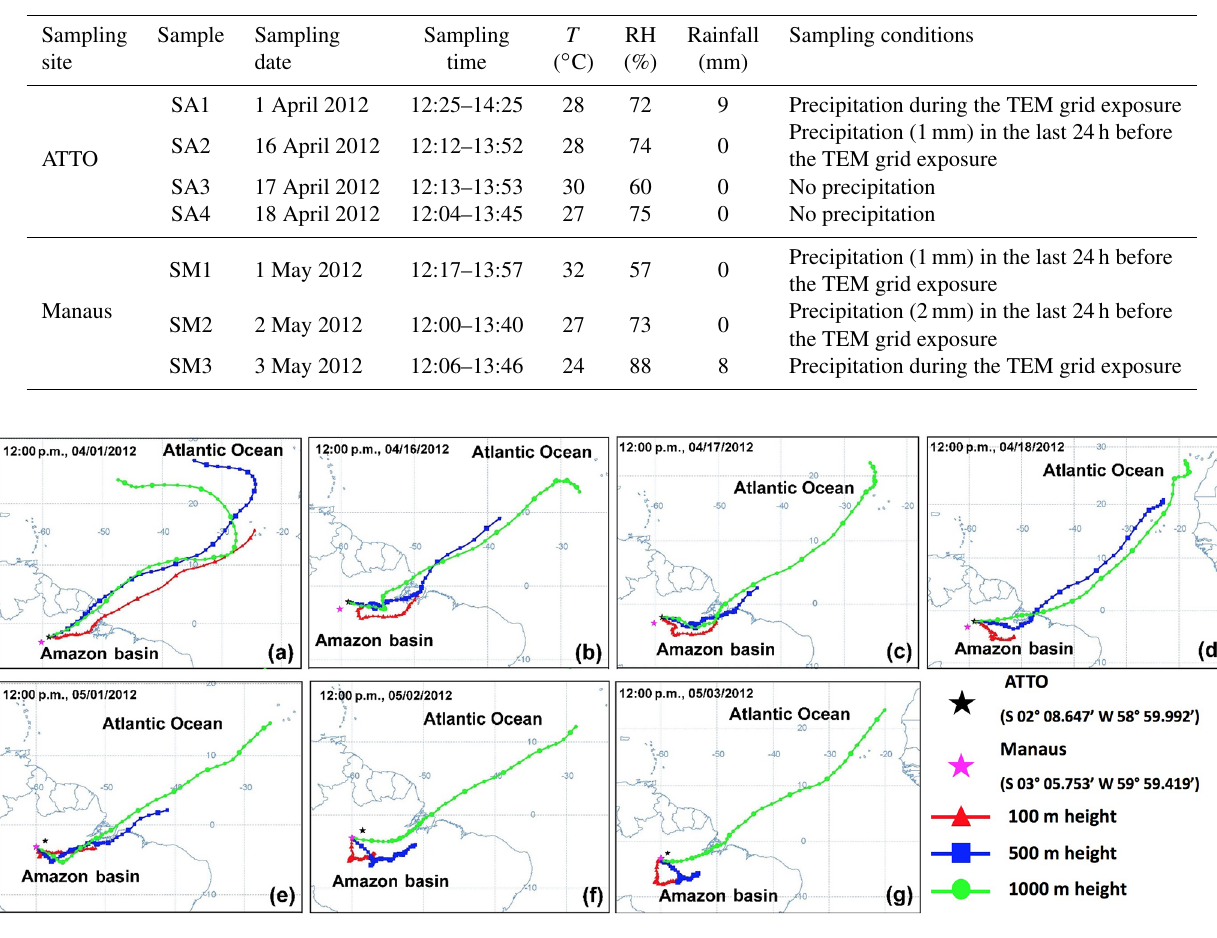
Table 1. Sampling dates, sampling times, and metrological conditions during the samplings.